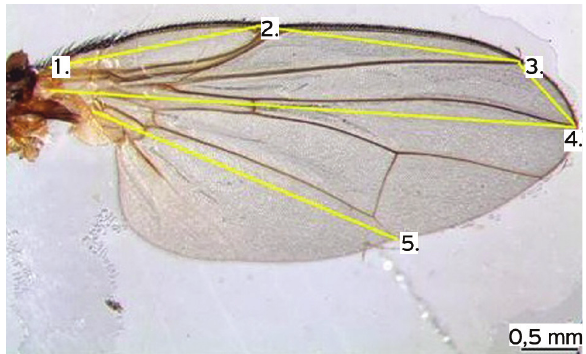
Figura 4. Pontos utilizados na morfometria alar de Neosilba perezi : 1) da parte externa da nervura umeral (h) até nervura subcostal (Sc); 2) da nervura subcostal (Sc) até a parte externa da nervura Radial 2 (R2); 3) da nervura Radial 2 (R2) até a parte externa da Radial 3 (R3); 4) deste último ponto (R3) até a parte inferior anterior da nervura média (MA); e 5) nervura que se localiza entre a célula Dm e